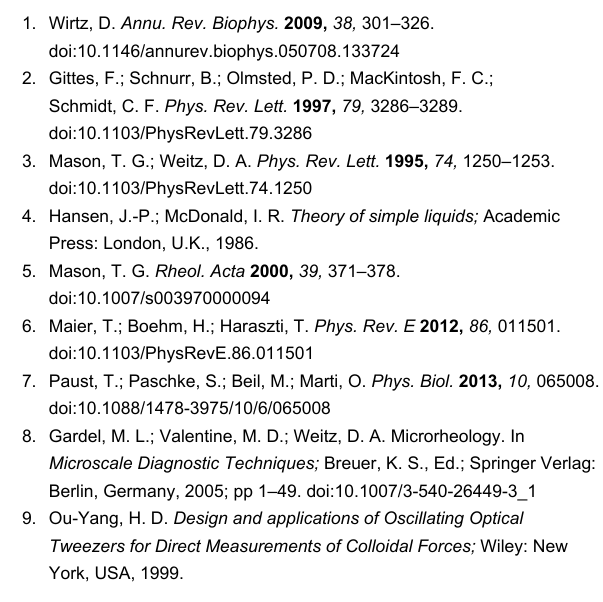
Figure 4: A) Three types of in vitro assembled keratin networks with different amounts of crosslinker (left 0 mM, center 0.25 mM, right 1 mM Mg 2+ ). The scale bar for all three pictures shows a length of 500 nm. B) Setup of the measurement device (optical tweezers). The laser beam is focused into the sample to allow for the trapping of microspheres. An acousto-optical deflector (AOD) ensures the oscillation of the laser beam with its pivot in the back focal plane of the objective. The CCD high-speed camera records the motion of the microspheres embedded in the examined medium. An addi- tional photodiode is used for the calibration of the trap. C) Image of a microrheology measurement. The white lines show the trajectories of the parti- cle motion. The length of the scale bar is 10 µm.